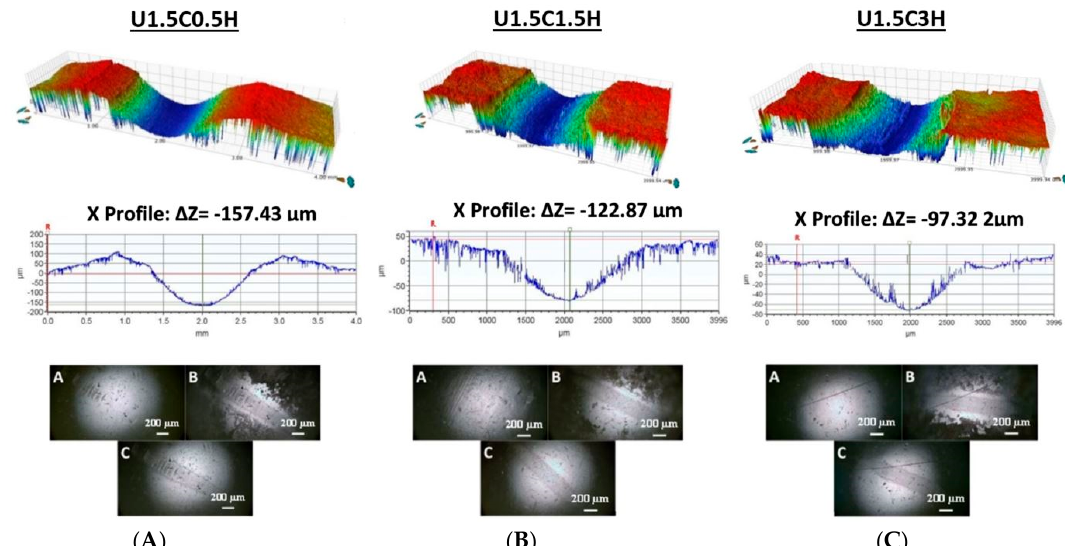
Figure 9. Average wear life of hybrid nanocomposite coatings, recorded after a wear test conducted at a normal load of 12 N, and a sliding velocity of 0.1 m/s for 250,000 cycles.